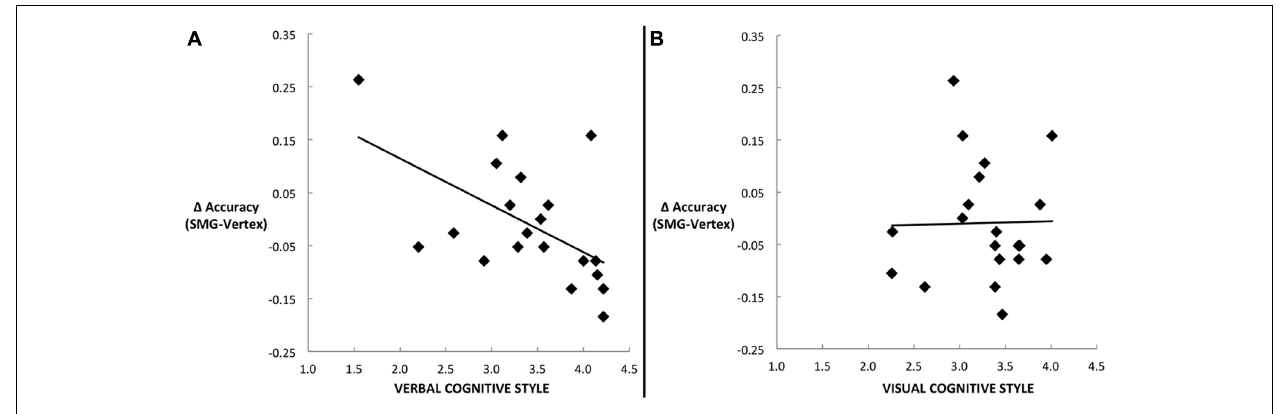
FIGURE 3 | Scatter plots depicting the correlation between the decline in task performance for the picture–word condition as a result of left SMG rTMS and (A) the verbal cognitive style ( r = − 0.56, p = 0.01), or (B) the visual cognitive style ( r = 0.02, p = 0.93).